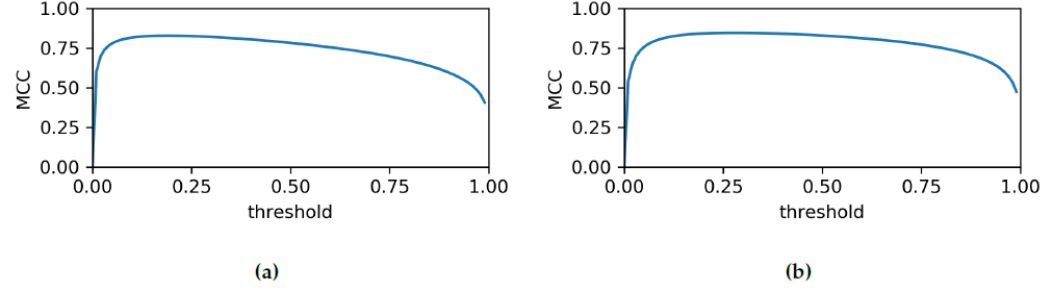
Figure 10. Matthews Correlation Coefficient (MCC) for varying classification thresholds based on ( a ) radiance, and ( b ) normalized radiance.